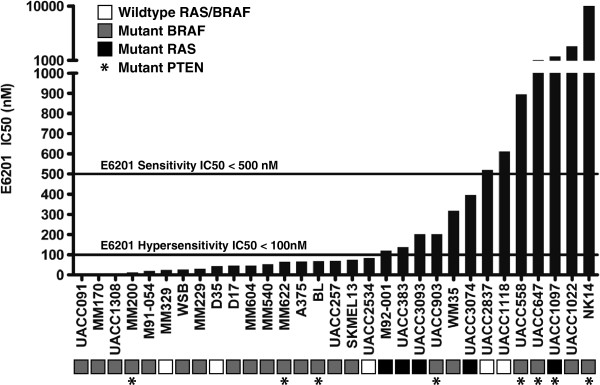
 Sensitivity of a melanoma cell line panel to E6201. The in vitro cell viability for all 31 cell lines studied was determined by MTS or Sulforhodamine-B (SRB) assay (for MM329). IC50 < 500 nM was considered sensitive and IC50 < 100 nM was considered hypersensitive.